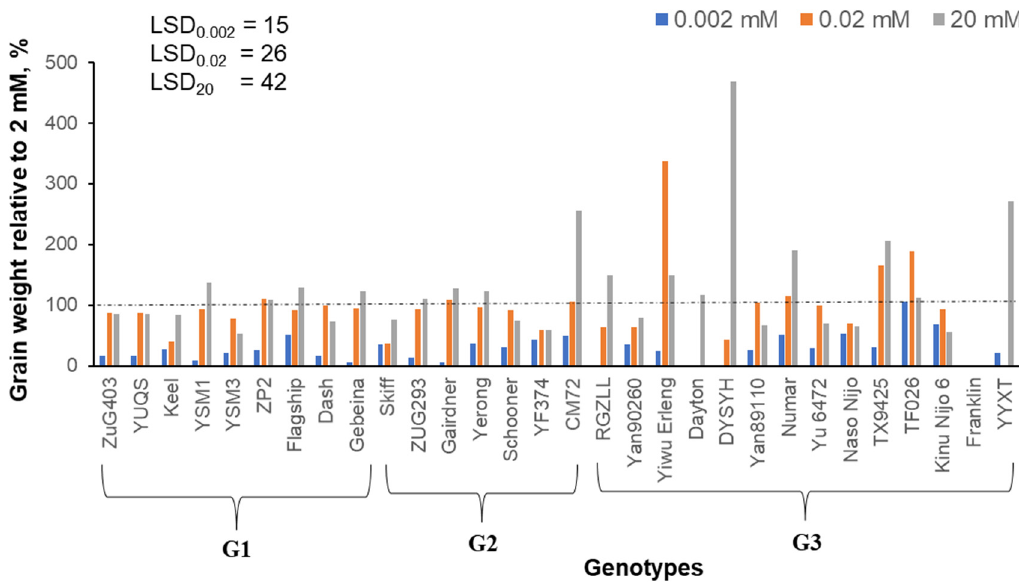
Figure 4. Relative grain weight of 30 barley genotypes grown at different K levels (0.002 mM, 0.02 mM and 20 mM) as compared to optimal 2 mM treatment. Genotypes were divided into three groups G1, G2 and G3 (see Figure 1 for details) produced by cluster analysis. Data are means ± SE ( n = 6). LSD are based on significance at p < 0.05 level. Table 4. Genotypic variation in the grain weight g/plant of barley genotypes under different con- centration of K + supply. Values are mean ± SE (n = 6) and G represents different groups of genotypes. Genotypes have been divided into three group G1, G2 and G3 according to cluster analysis (see Section 3.1 and Figure 1).